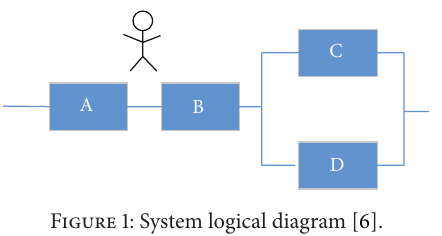
Figure 1: System logical diagram [6]. Table 1: Component parameters for the analysis [6].